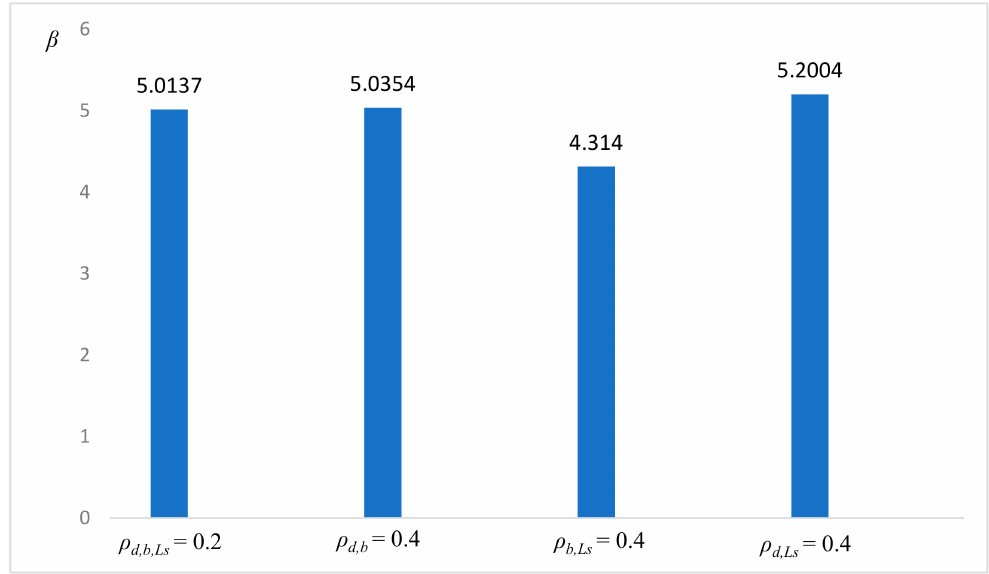
Figure 16. Comparison of three interaction parameters on the corroded